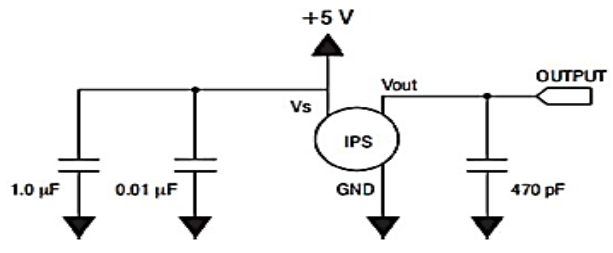
Figure A3. Conditioning capacitors for the pressure sensor [9].